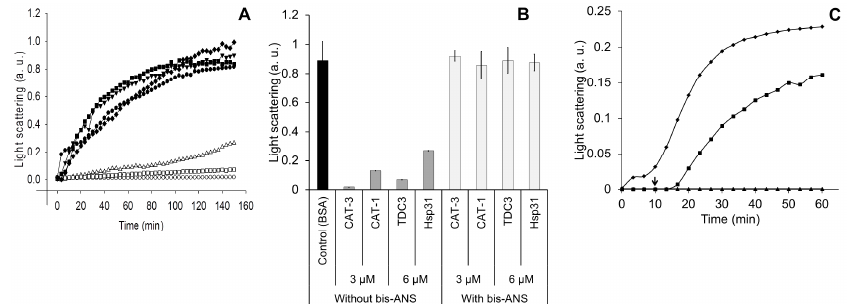
Figure 3. Proteins treated with the bis-ANS probe lost the ability to inhibit heat denaturation of ADH. ( A ) Light sca tt ering of ADH (6 µM) when heat denatured (45 °C) in the presence of chaper- ones with the bis-ANS incorporated covalently. Hsp31, CAT-1, CAT-3, and TDC3 (3 and 6 µM) were incubated with bis-ANS (1.2 µM) at 45 °C for 30 min and thereafter irradiated with UV light (366 nm) for 10 min at RT. ADH with BSA (6 µM) (closed circles), CAT-3 (3 µM) without bis-ANS (open circles), CAT-3 (3 µM) with incorporated bis-ANS (closed triangles); TDC3 (6 µM) without bis-ANS (open squares), TDC3 (6 µM) with incorporated bis-ANS (closed rhomboids); Hsp31 (6 µM) without bis-ANS (open triangles), and Hsp31 (6 µM) with incorporated bis-ANS (closed squares). ( B ) Aver- age of three independent assays. ( C ) Light sca tt ering of ADH (6 µM) when denatured at 45 °C for 150 min in the presence of BSA (6 µM) (rhomboids), TDC3 (6 µM) (triangles), and TDC3 (6 µM) but adding bis-ANS (1.2 µM) 10 min after starting the reaction (indicated by arrow) (squares). To avoid photo-incorporation of the bis-ANS probe, light sca tt ering was determined at 500 nm in this assay.